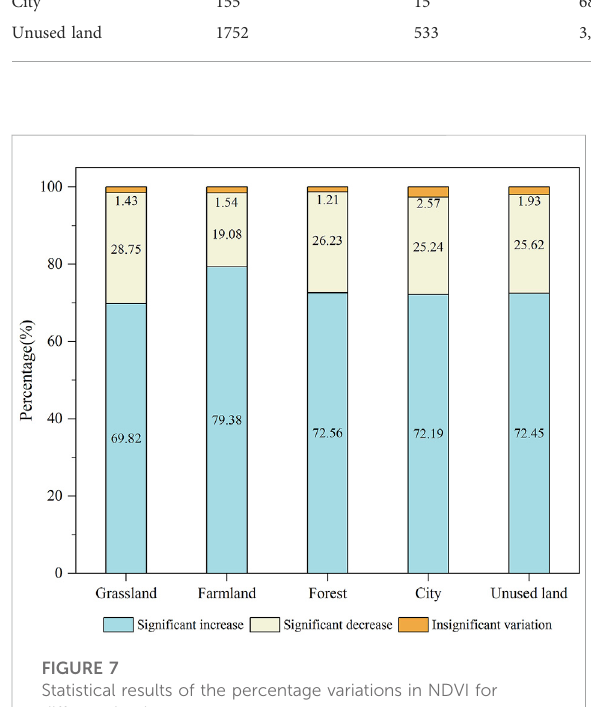
FIGURE 7 Statistical results of the percentage variations in NDVI for different land use types.